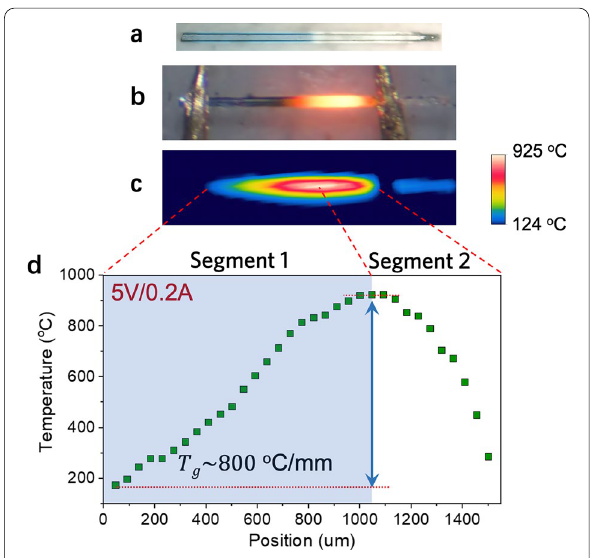
Fig. 3 a Optical image of the microwire with doping gradient. b Optical image and c IR image of the microwire under Joule heating. d The temperature distribution along this